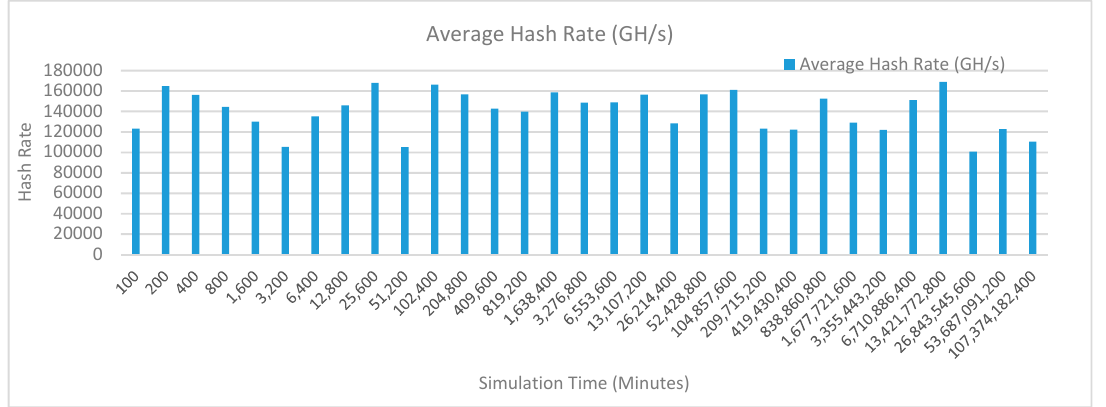
Figure 23. Average hash rate analysis (with IoT, edge, fog, and cloud).